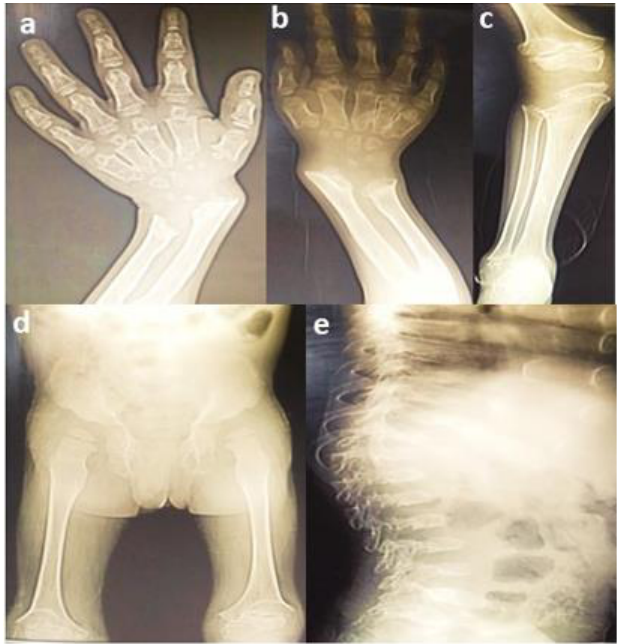
Figure 3. Radiographs of proband: ( a ) hand radiograph showing short phalanges, pointed metacarpals and underdeveloped carpal bones; ( b ) bowing of radius and mesomelia; ( c ) small femoral epiphyses, metaphyseal abnormality of the knees, flared distal ends of the femurs; ( d ) sloping of tibia; and ( e ) curvature of spine, short height vertebral bodies and platyspondyly with beaking of vertebral bodies.